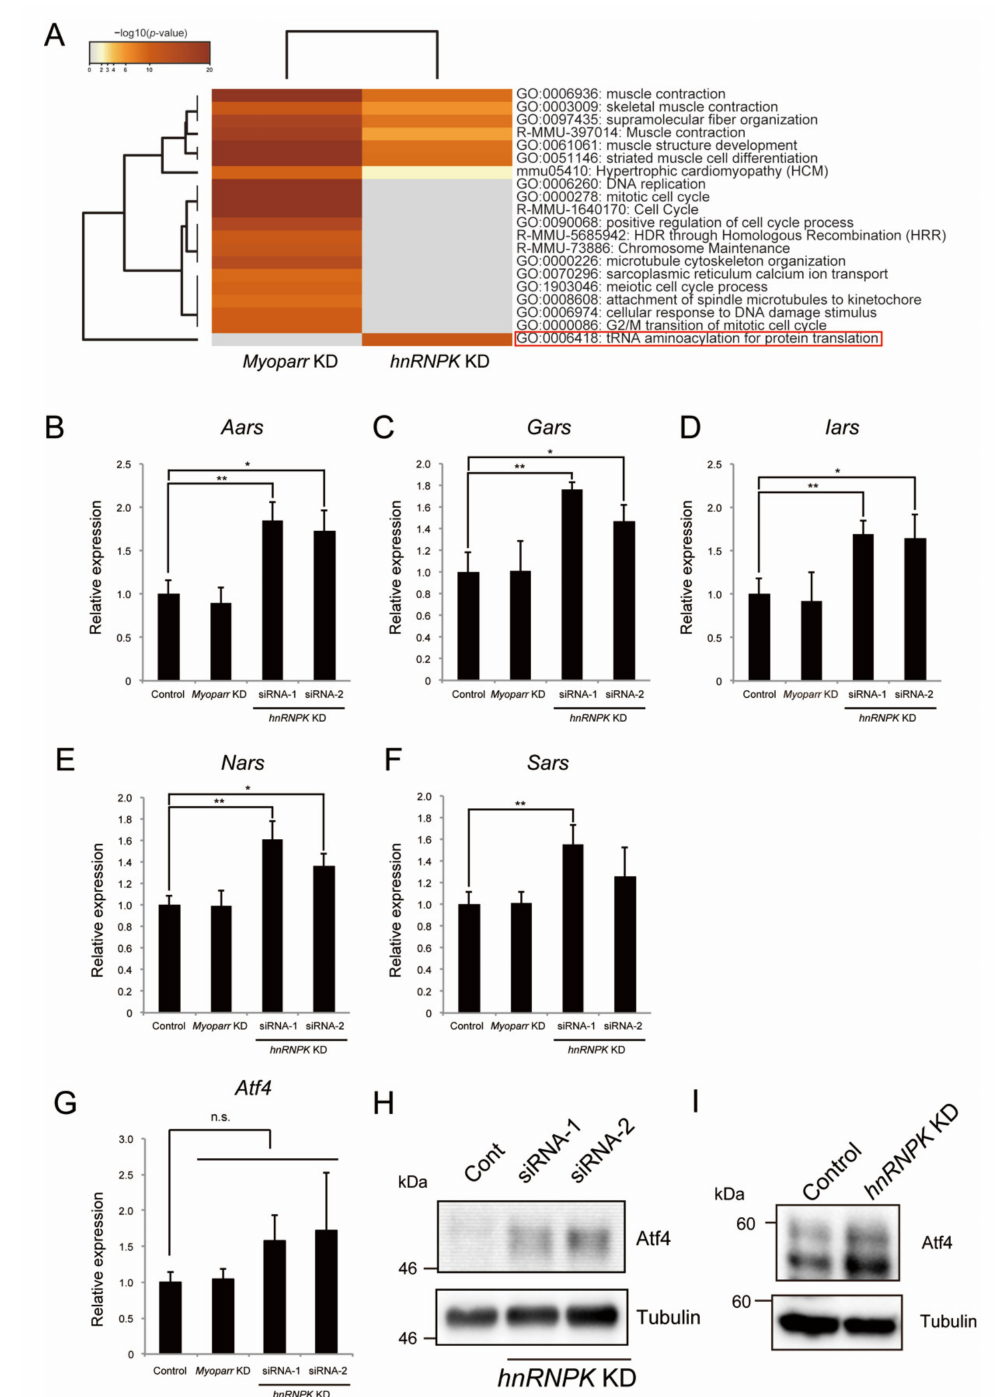
Figure 5. hnRNPK regulates the expression of genes coding for aminoacyl-tRNA synthetases in a Myoparr -independent manner. ( A ) A Metascape analysis of genes regulated by Myoparr KD and hnRNPK KD. The red frame indicates the GO terms that were specifically enriched in hnRNPK KD. ( B – G ) qRT-PCR to detect the expression of Aars ( B ), Gars ( C ), Iars ( D ), Nars ( E ), Sars ( F ), and Atf4 ( G ) 48 h after either Myoparr KD or hnRNPK KD. n = 3, mean ± SD. ** p < 0.01, * p < 0.05, n.s., not significant. ( H , I ) Western blot showing the increased expression of Atf4 in differentiating C2C12 cells ( H ) and mouse primary myoblasts ( I ) 48 h after hnRNPK KD. The tubulin expression served as an internal control. Blots are representative of three